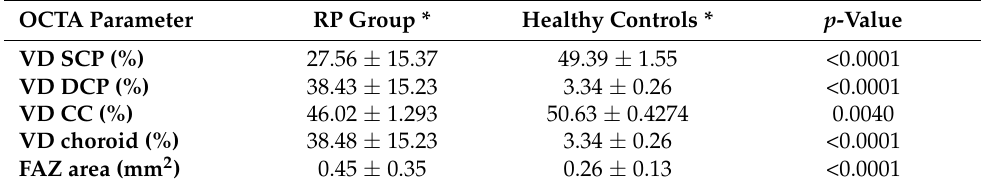
Table 3. Differences in OCTA parameters between patients with retinitis pigmentosa and healthy controls. OCTA Parameter